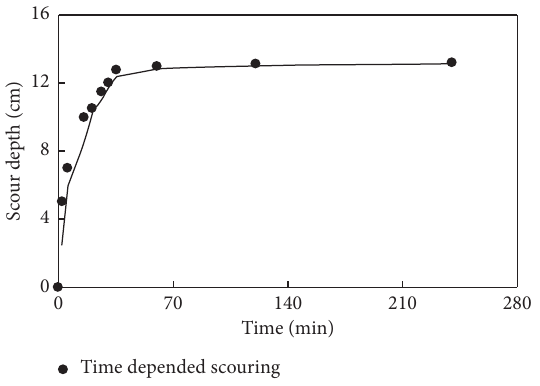
Figure 7: The changes in the scour depth with time. Table 2: Relations for determining the scour depth downstream of hydraulic structures [14].